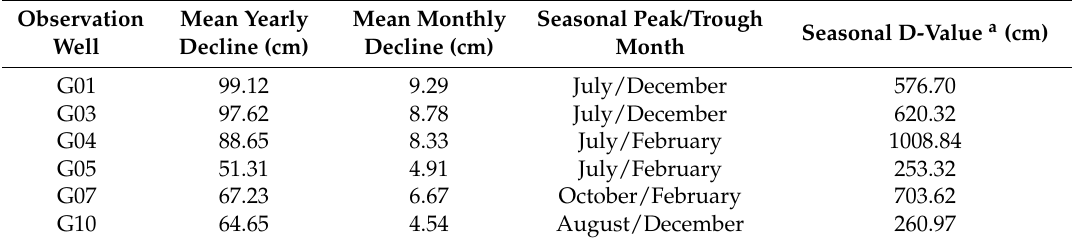
Table 3. Groundwater well cases, mean yearly and monthly decline, seasonal peak/trough month and seasonal D-value, 2002–2014.